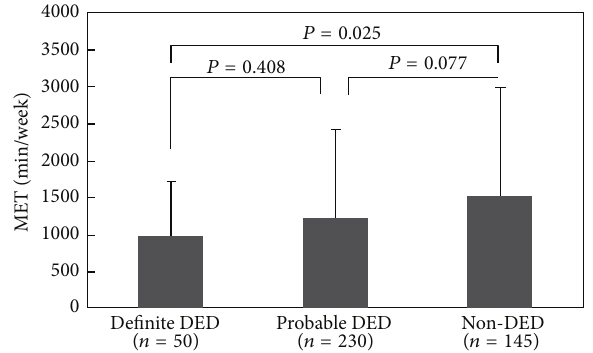
Figure 1: Comparative analysis of MET score and dry eye disease. Each column shows the mean ± SD. 𝑃 values were analyzed by Tukey’s multicomparisonsfollowing ANOVA. DED: